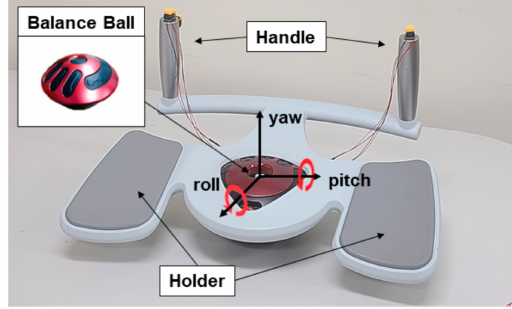
Figure 1. The components of the balance